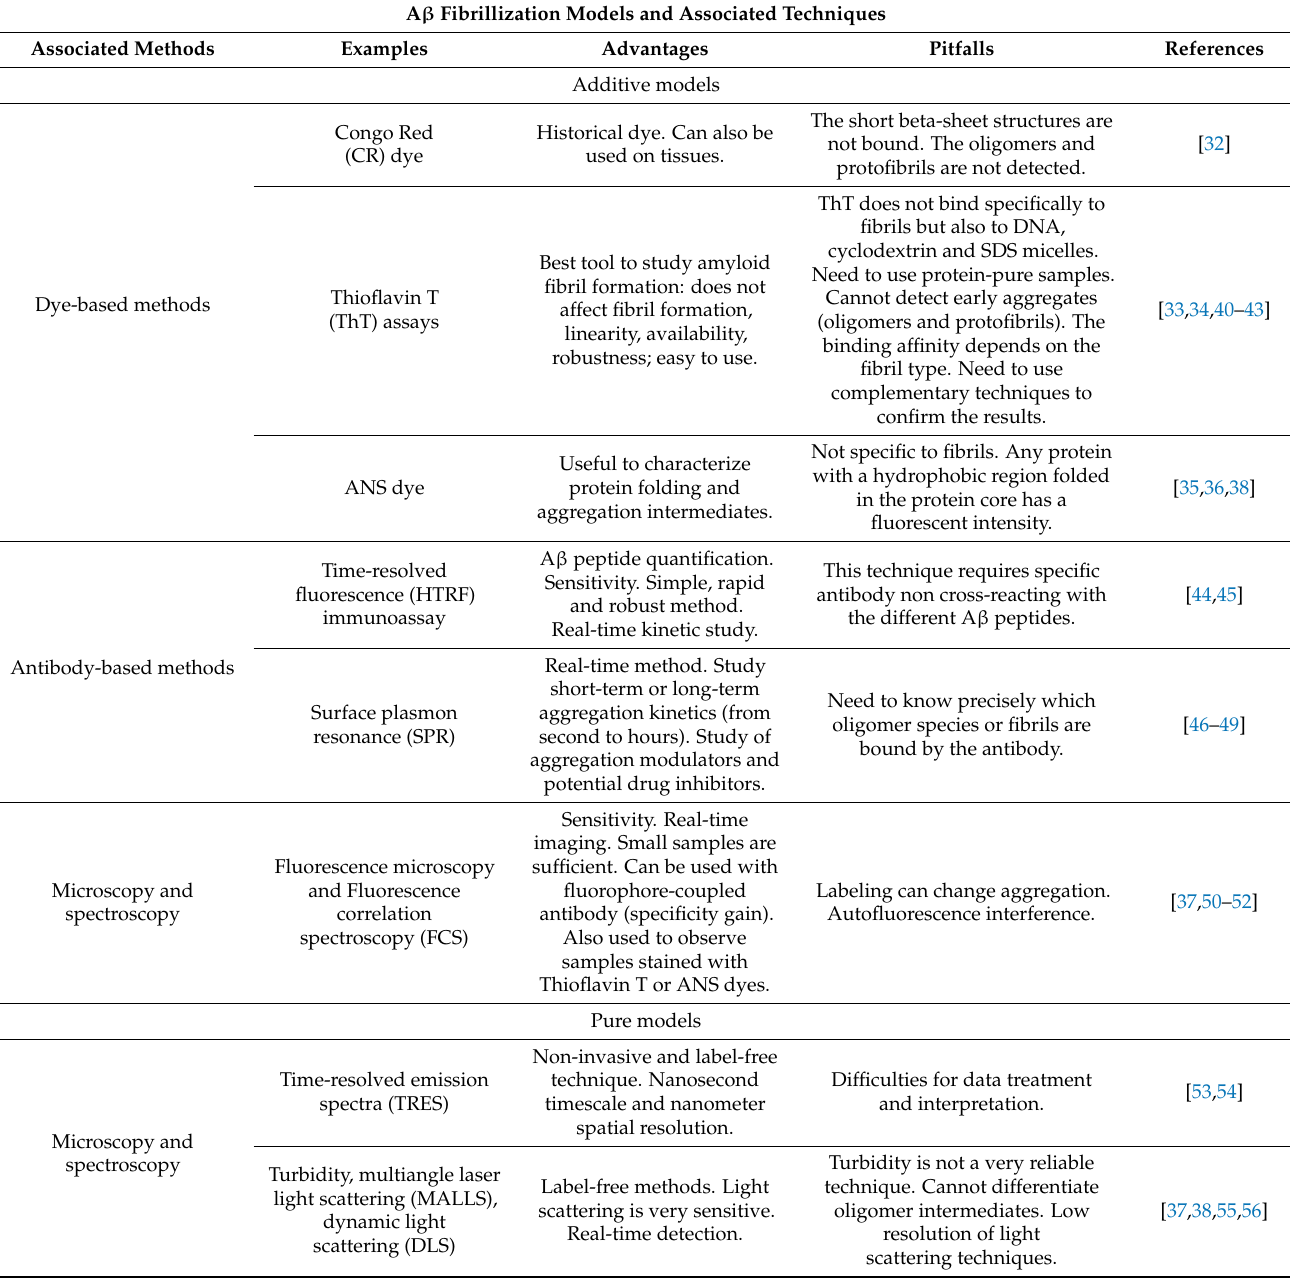
Table 1. In vitro models of A β amyloid fibril formation and the associated biophysical techniques, based on the reviews of Malmos et al. (2017), Bruggink et al. (2012), Siddiqi et al. (2019), and Kumar et al. (2017)